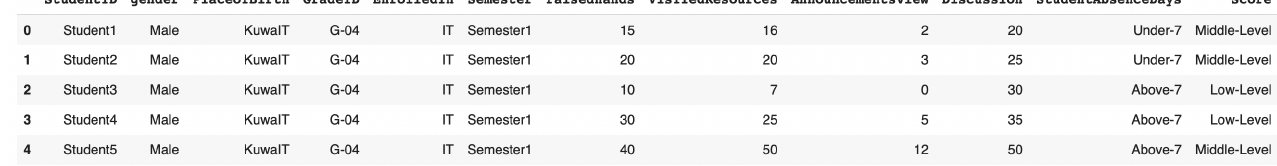
Figure 6. First five rows of the dataset after feature